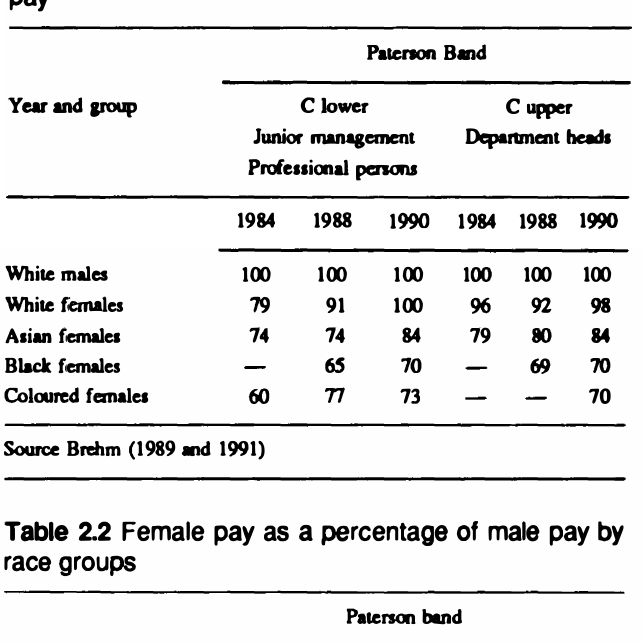
Table 2.2 Female pay as a percentage